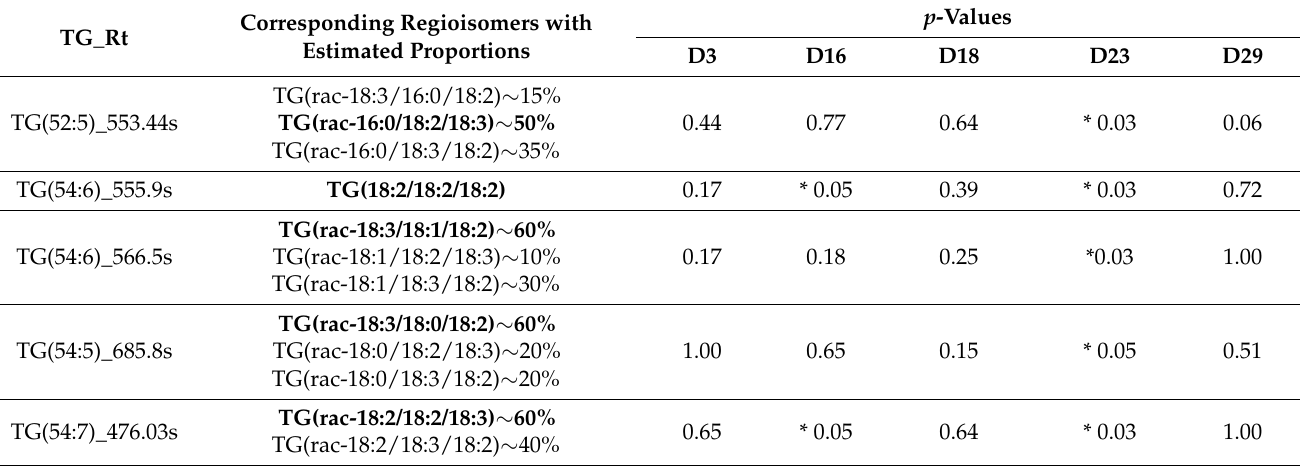
Table 4. Results from the TG platform, with associated p -values from a Wilcoxon test. *: p -value ≤ 0.05. For each TG signal, the corresponding regioisomers and associated estimated proportions are detailed. The main regioisomers are in bold. Corresponding Regioisomers with TG_Rt Estimated